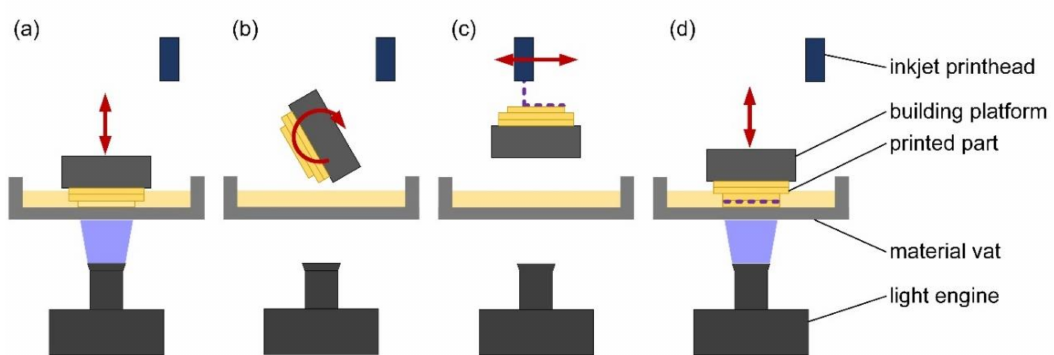
Figure 2. Workflow of the hybrid printing system. ( a) The building platform immerses into the vat and a resin layer is printed; ( b ) the building platform rotates upwards; ( c ) an inkjet layer is printed and fixated; ( d ) after rotating downwards, the ink layer is fully cured and the next resin layer is printed.